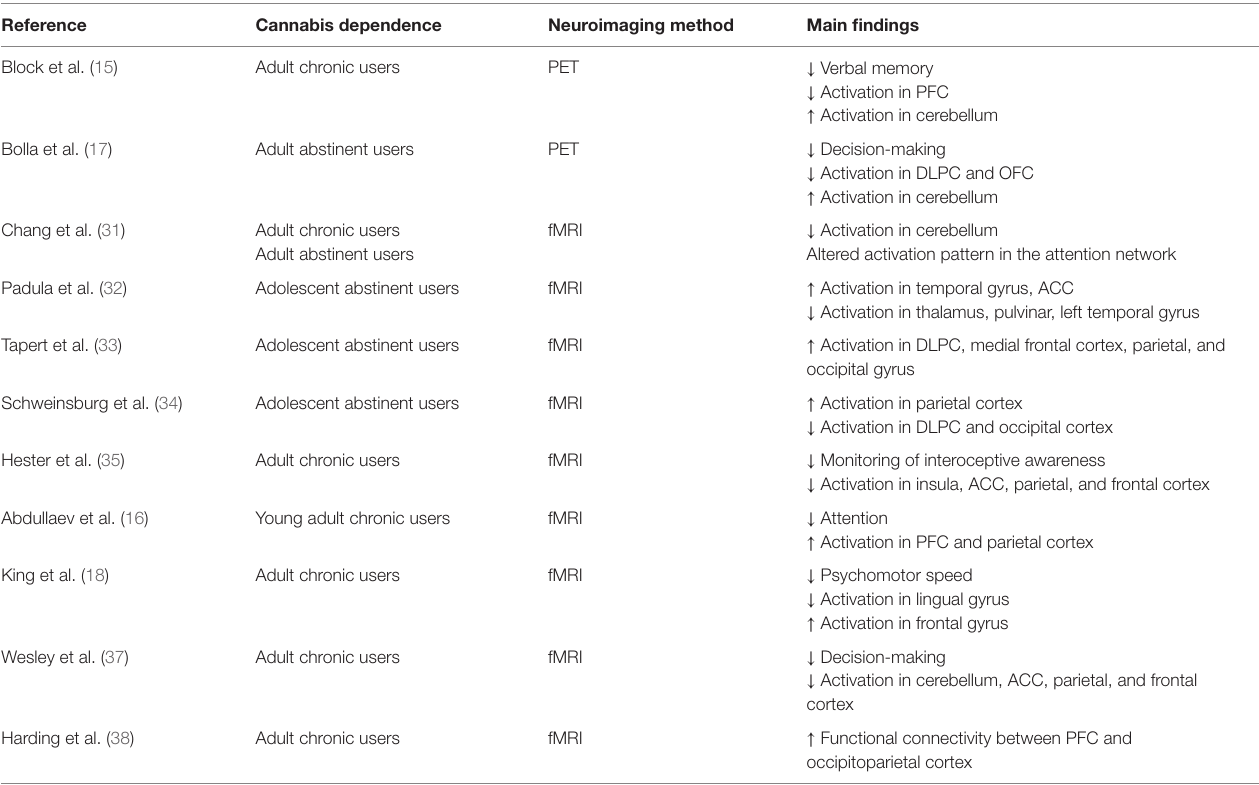
TABLe 2 | Functional neuroimaging studies on marijuana users performing cognitive